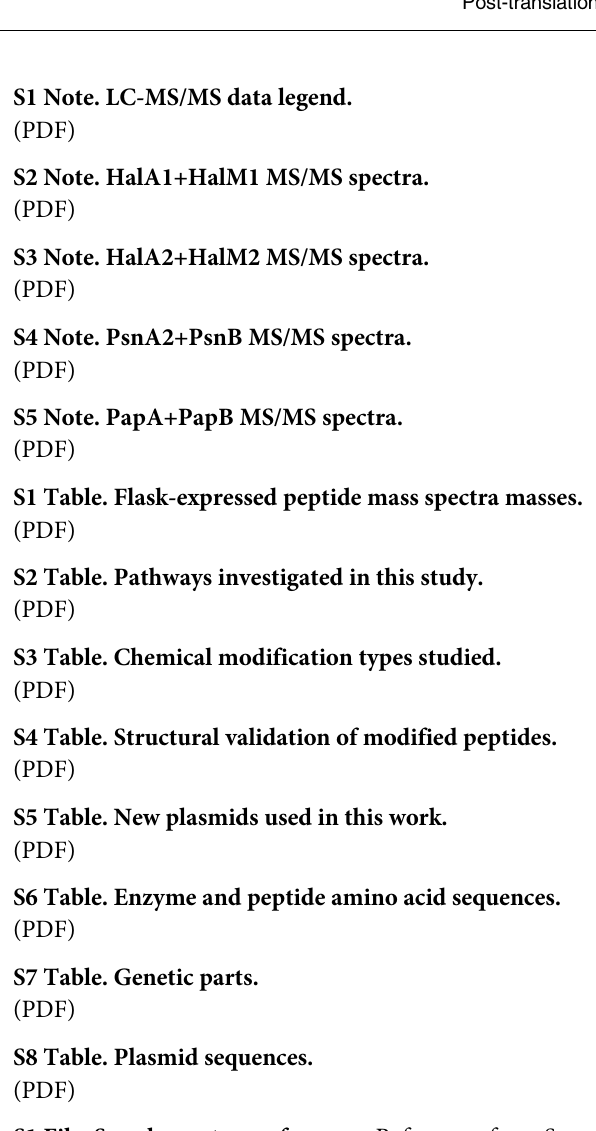
S1 Table. Flask-expressed peptide mass spectra masses. S2 Table. Pathways investigated in this study. S3 Table. Chemical modification types studied. S4 Table. Structural validation of modified peptides. S5 Table. New plasmids used in this work. S6 Table. Enzyme and peptide amino acid sequences. S7 Table. Genetic parts. S8 Table. Plasmid